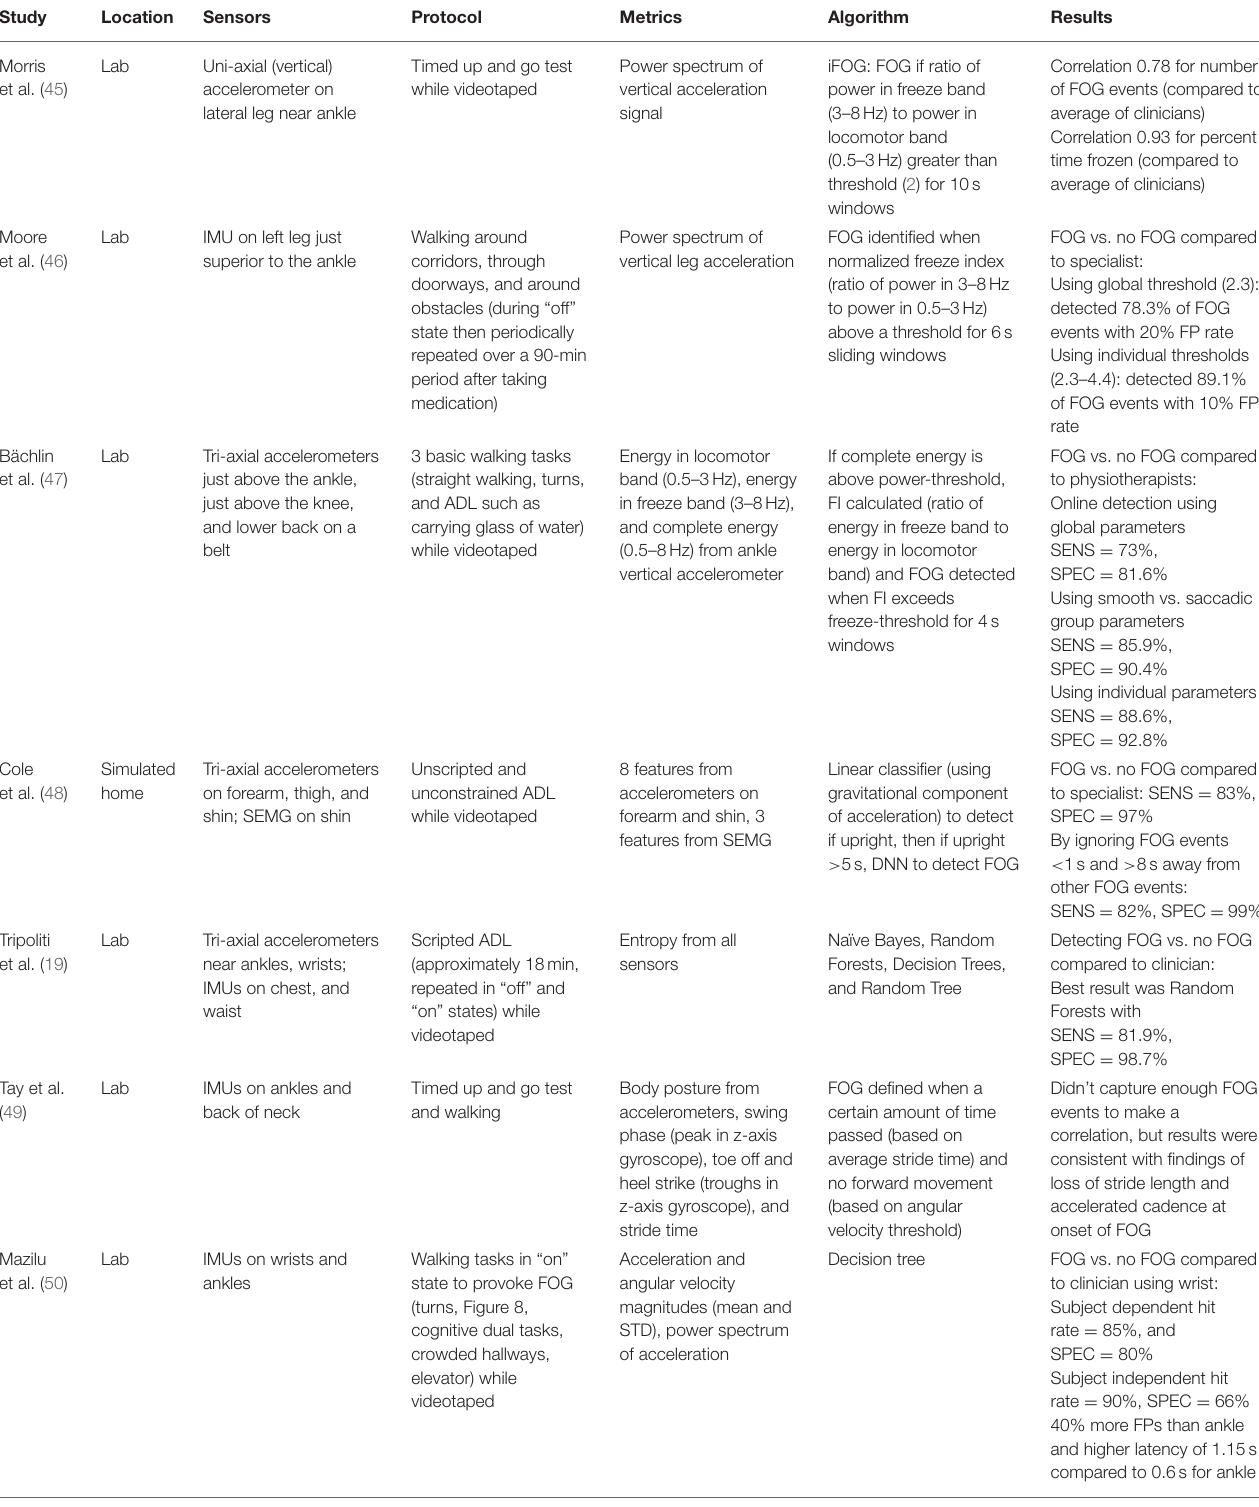
TABLE 4 | Studies on akinesia and/or freezing of